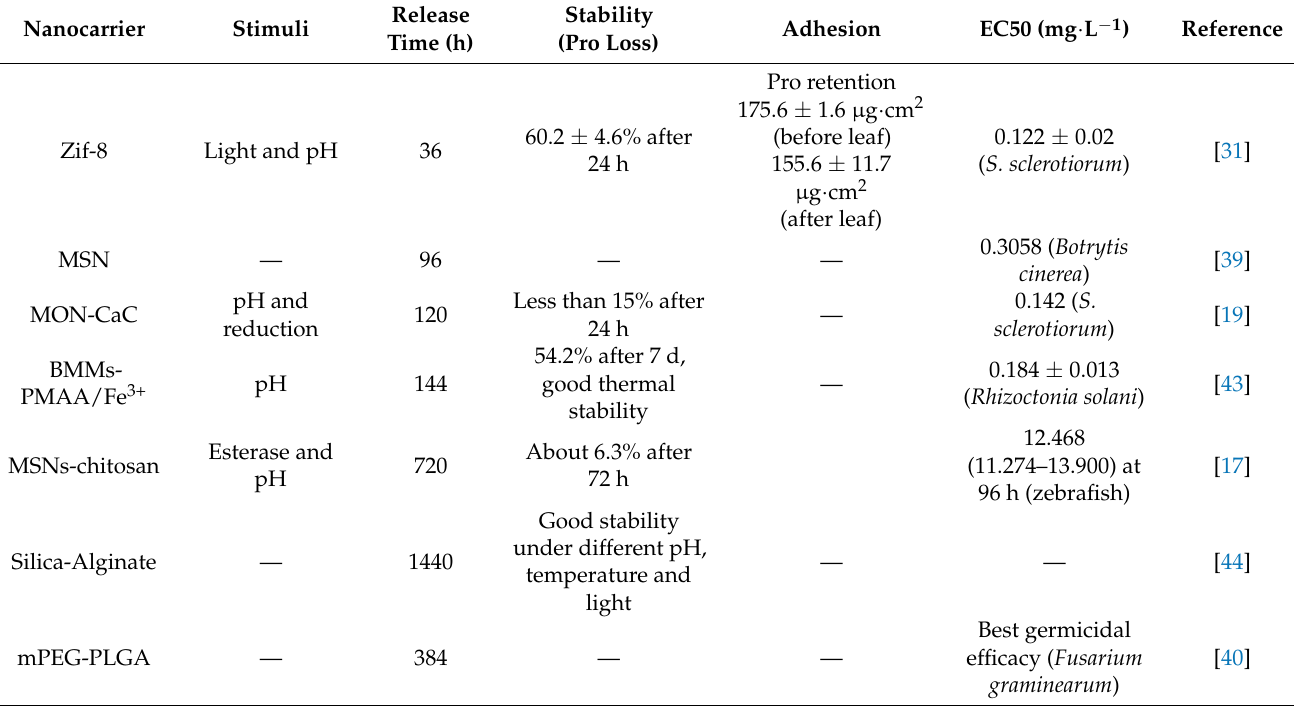
Table 2. Summary of nanosystems encapsulated with